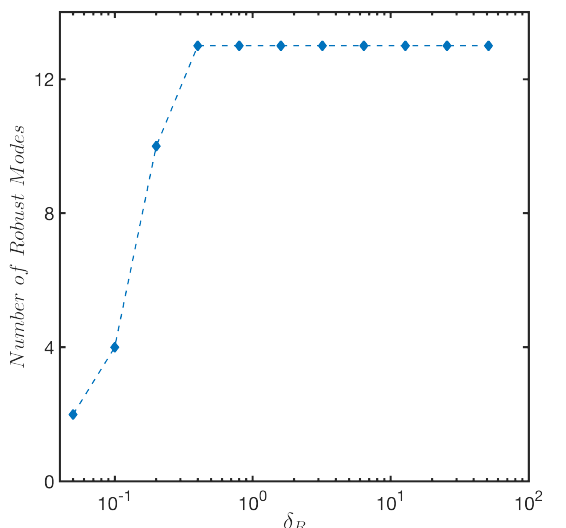
Figure 1. The number of robust modes found in the turbulent jet flow analyzed in Section 5 as a function of δ R when the cutoff ∆ is set at